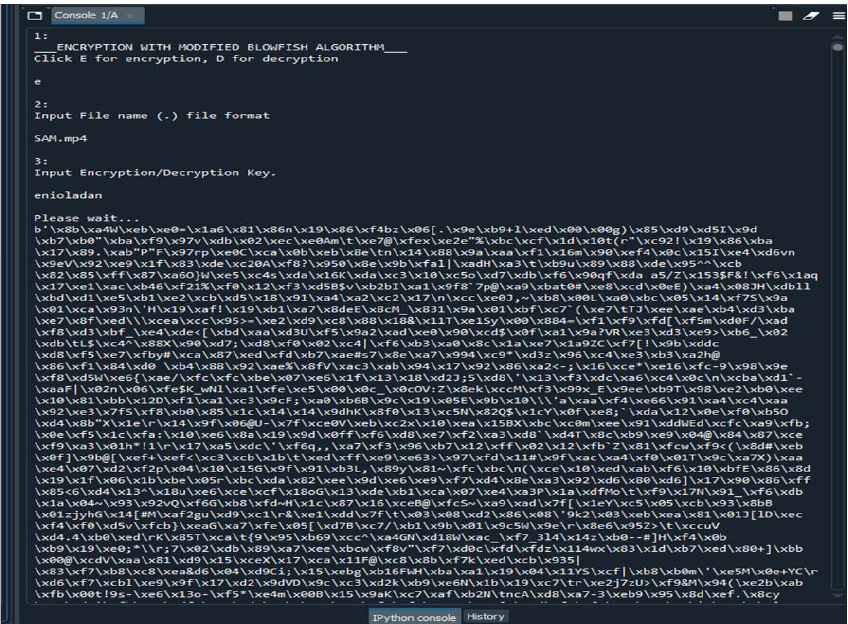
Figure 3. Video Selection Process on Application Terminal.